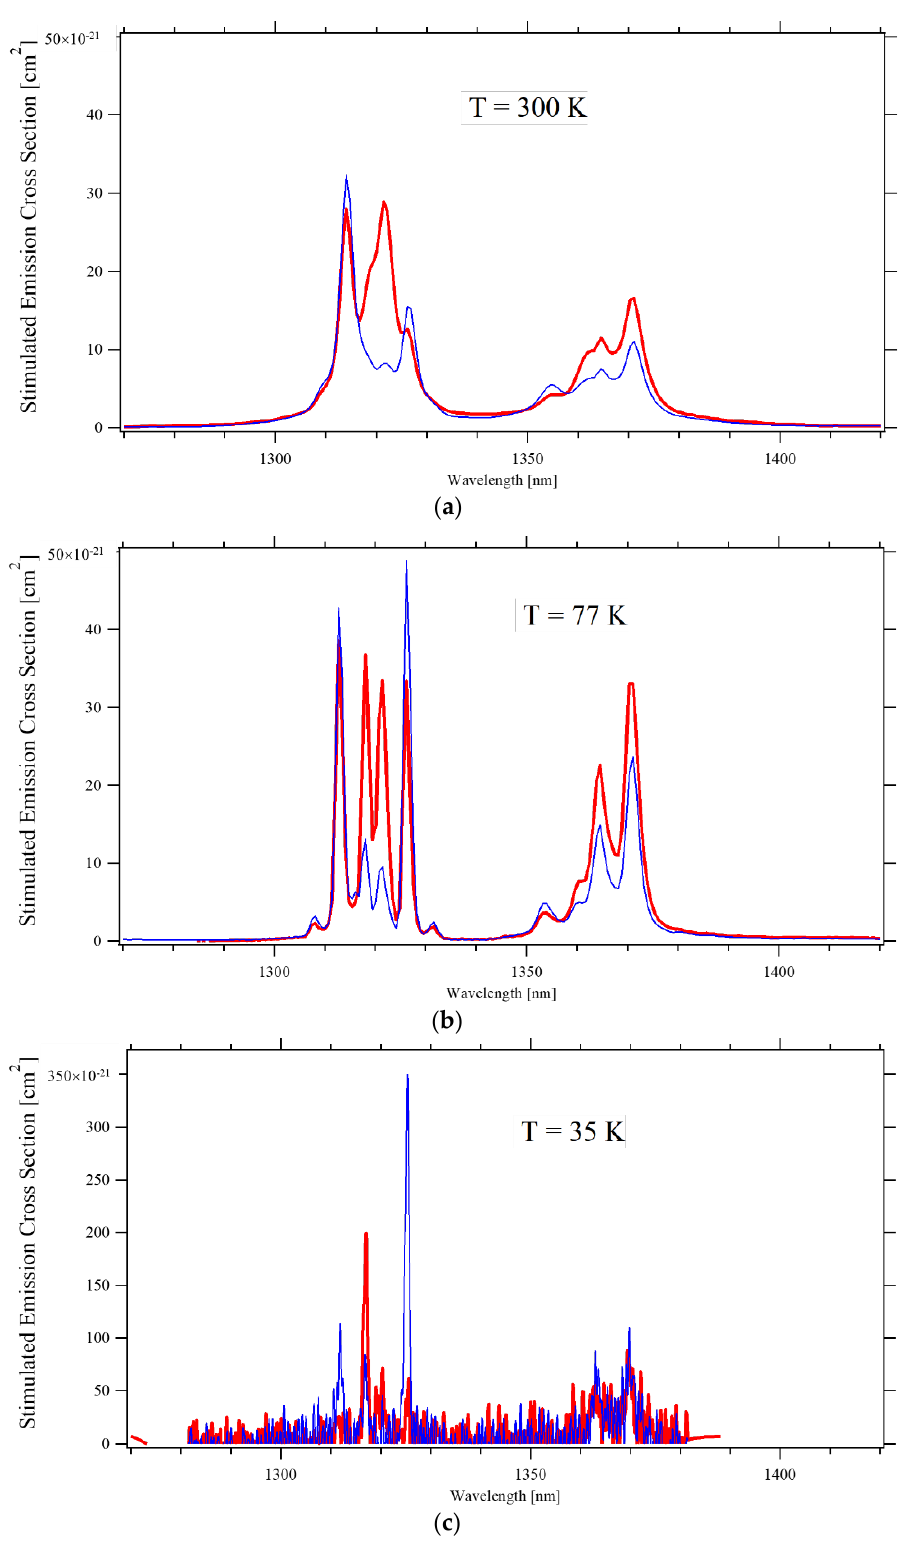
Figure 6. Emission cross-section of the 4 F 3/2 → the 4 I 13/2 transition for π –polarized (Red) and σ –polarized (Blue) light, at three temperatures: ( a ) T = 300 K; ( b ) T = 150 K; ( c ) T = 35